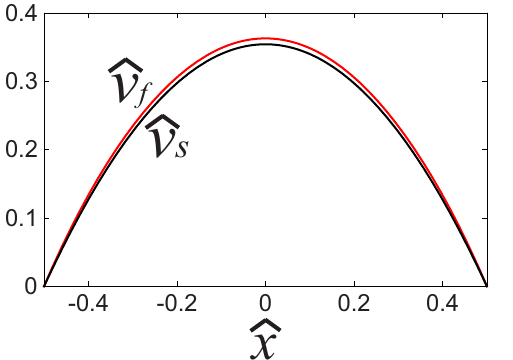
Figure 2. Dimensionless RBCs and fluid velocities in function of ˆ x obtained for ε s =